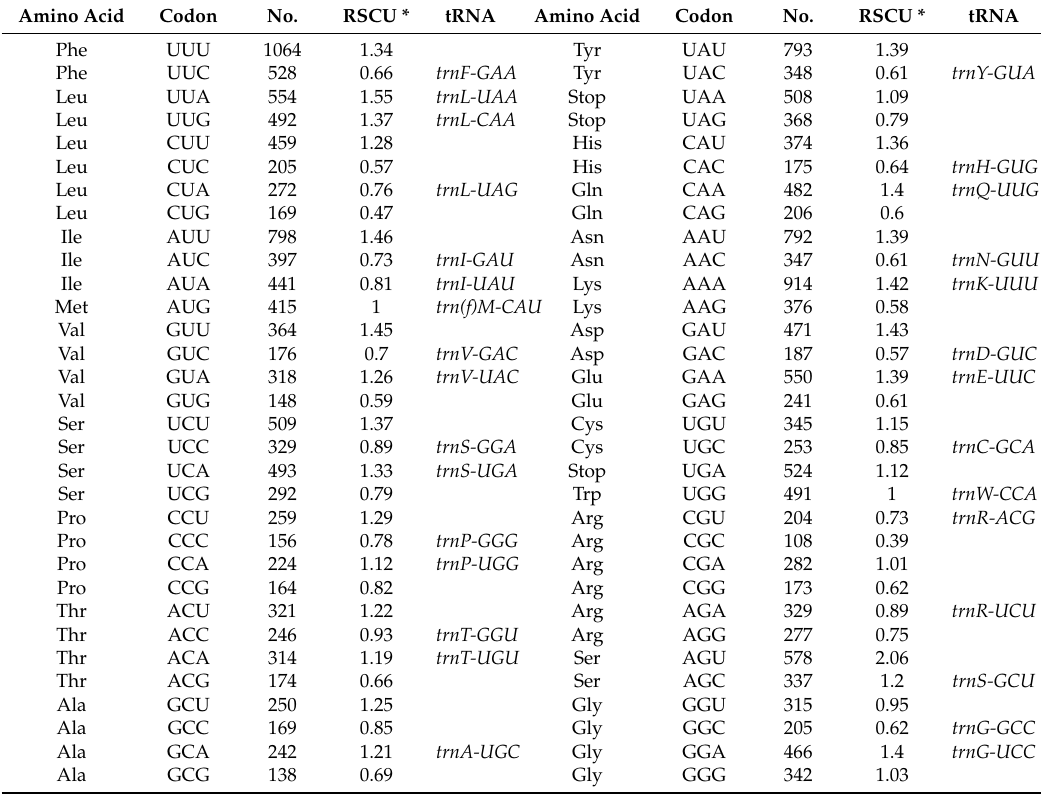
* RSCU: relative synonymous codon usage.